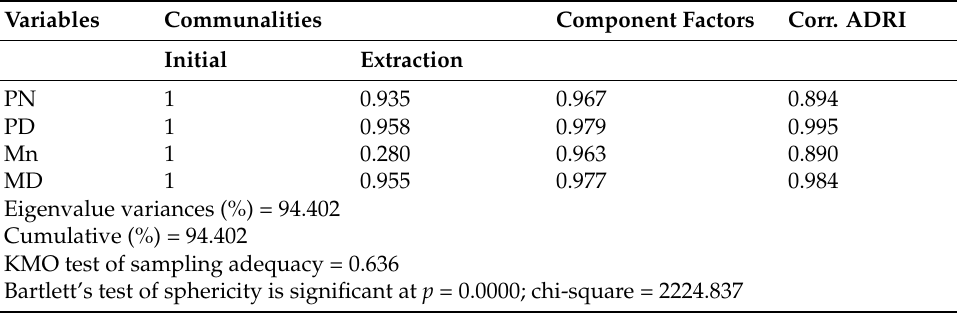
Table 4. Correlation matrix used for agricultural drought resilience index (ADRI).